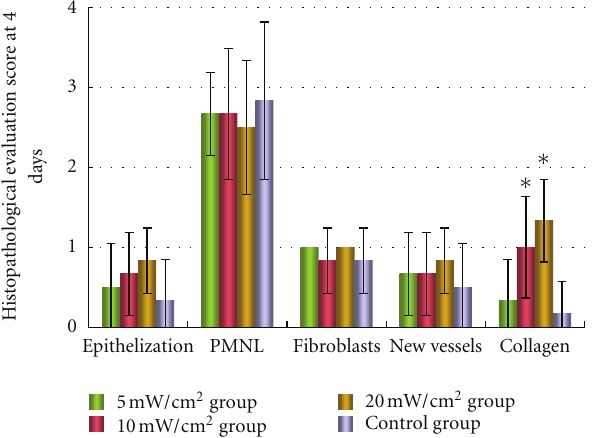
Figure 3: The semiquantitative histopathological evaluation score at 4 days after wounding. Asterisk means that this group has statistical di ff erence with control group ( P < 0 .